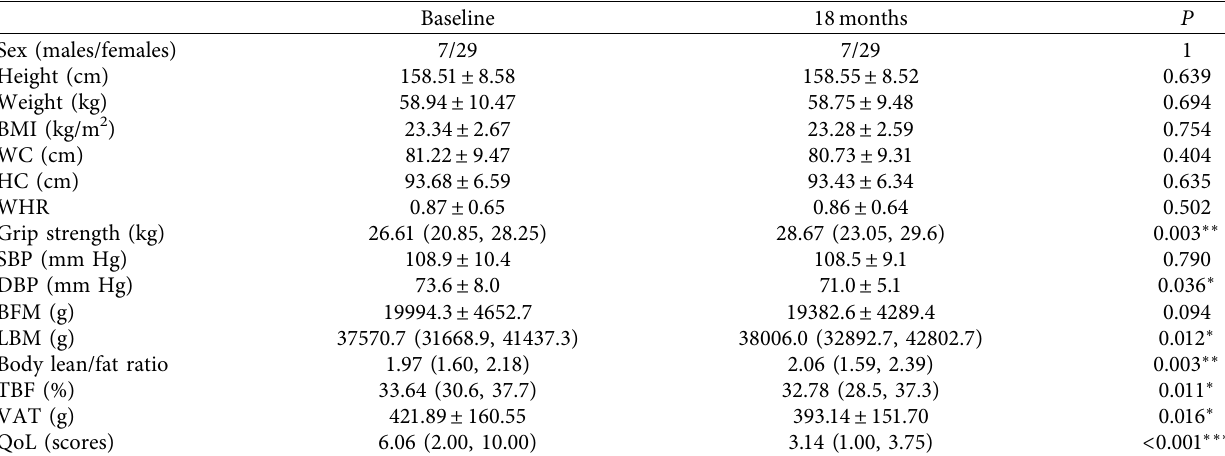
Table 3: Physical data, body composition, and QoL changes after 18months of rhGH replacement in 36